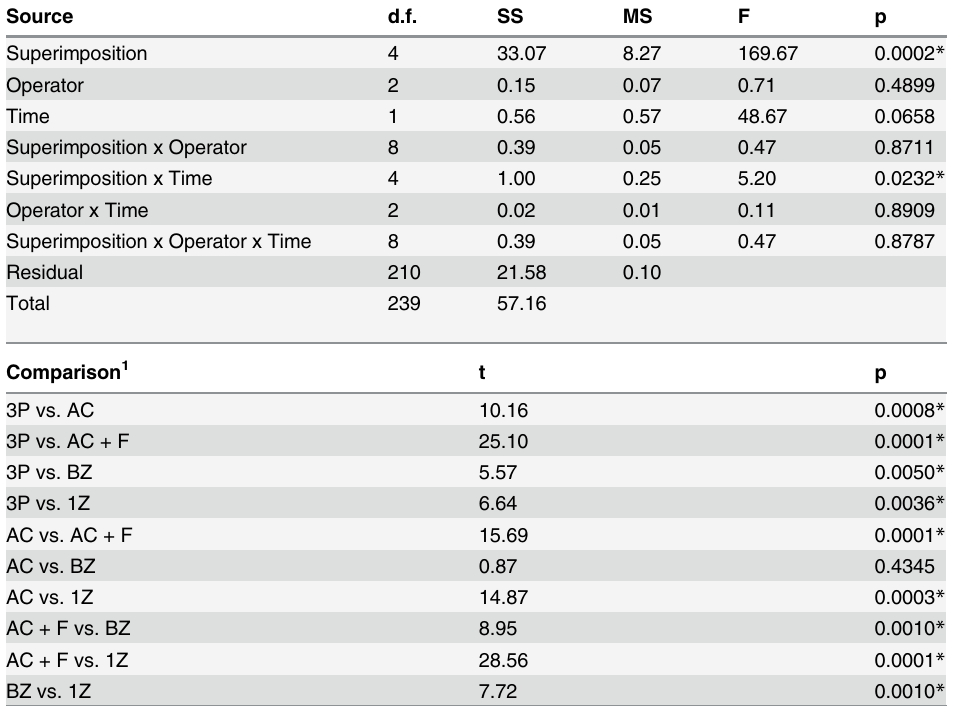
Table 1. Non parametric MANOVA on accuracy measurements (deviation between